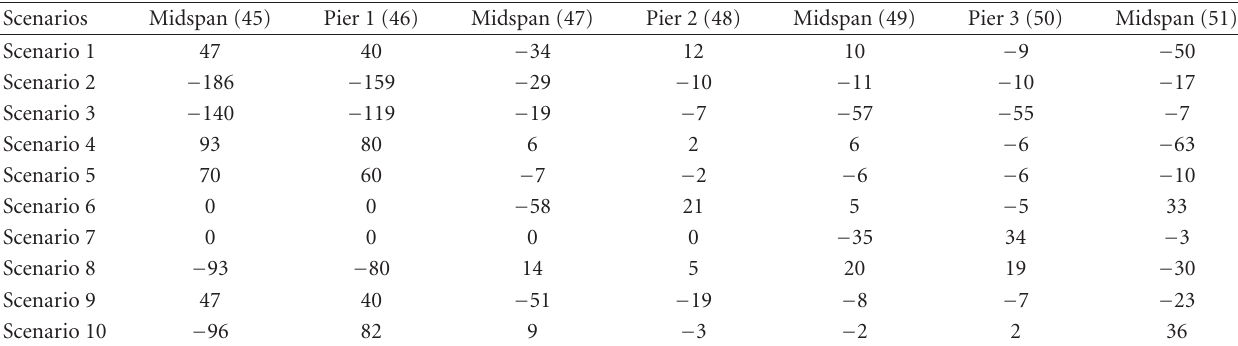
Table 4: Live load stresses from deflections (analytical)—south side panels (psi ∗ ).